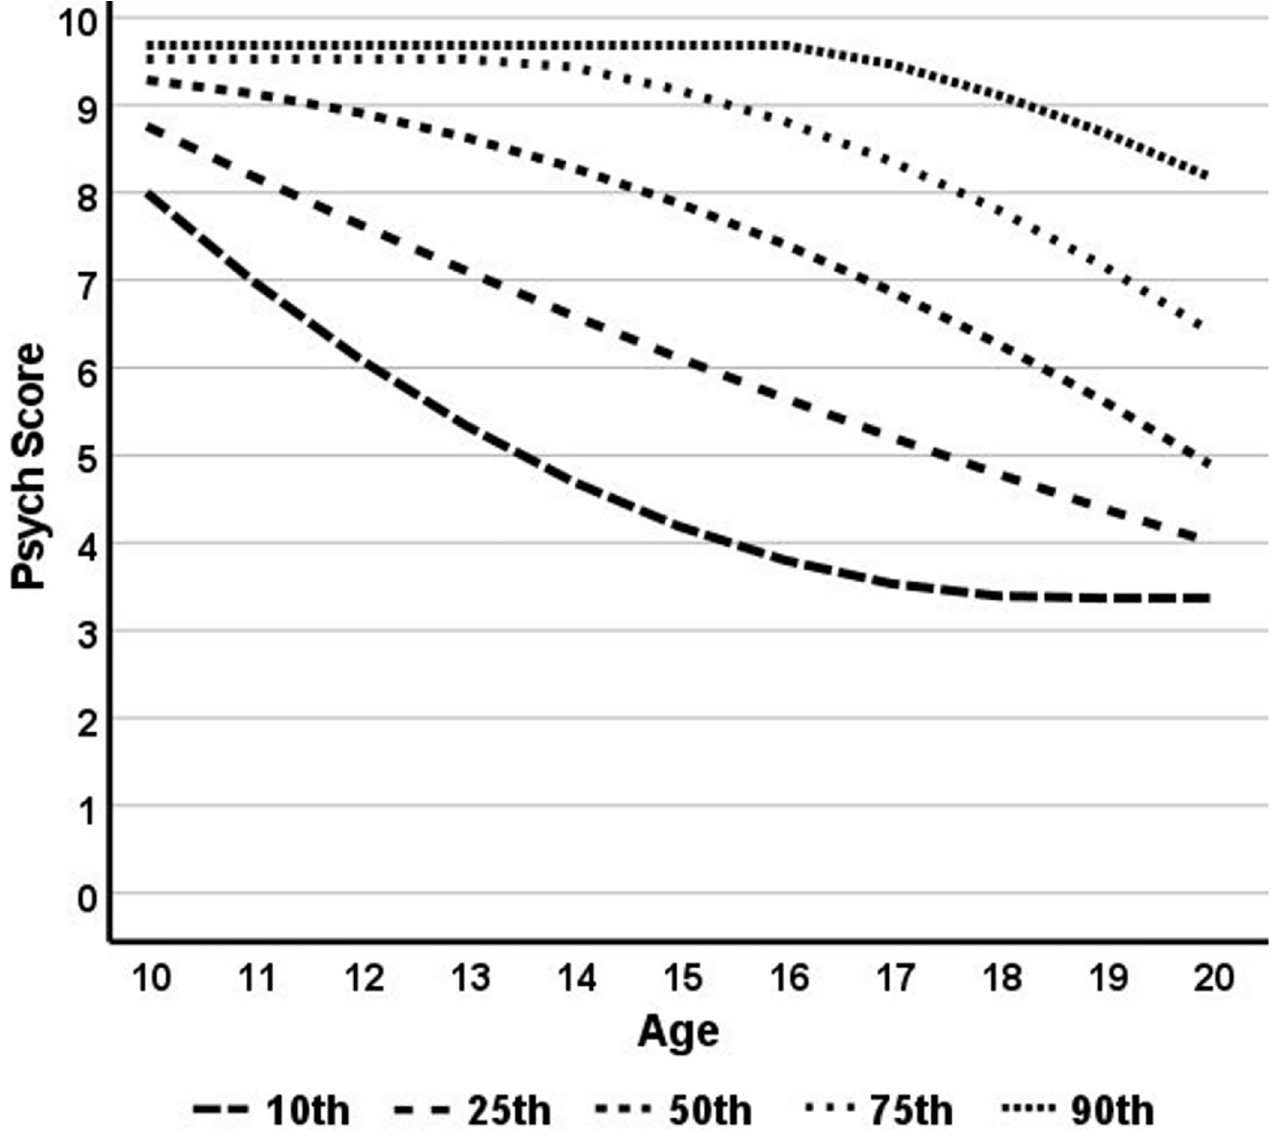
Fig 1. Changes in psych scores across ages for five sample